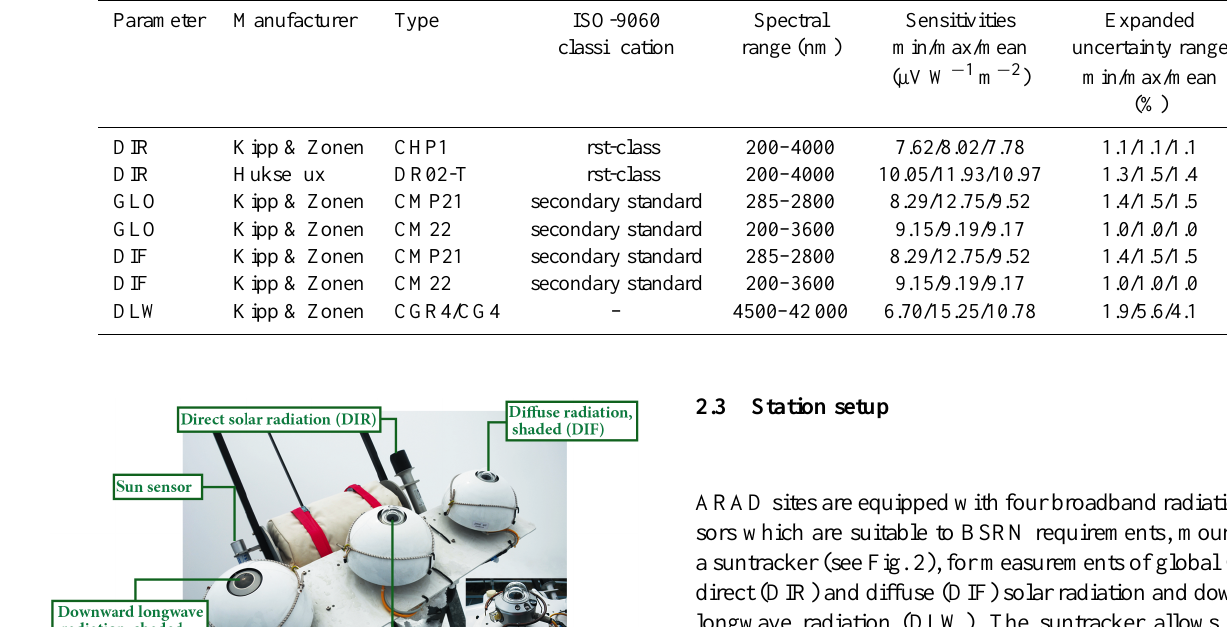
Table 1. List of measurement instruments used at ARAD stations.